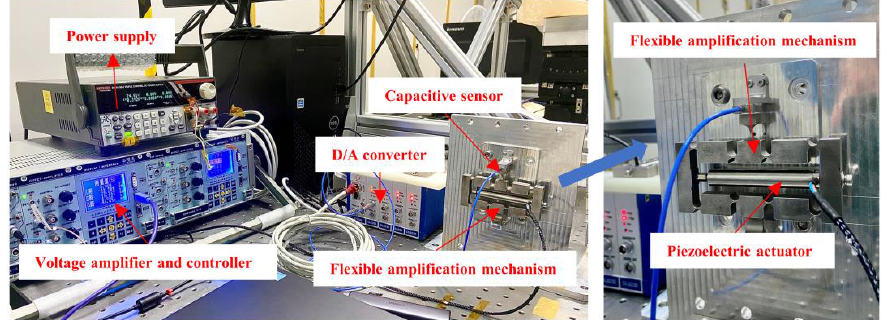
Figure 9. Experimental system of amplification ratio function.